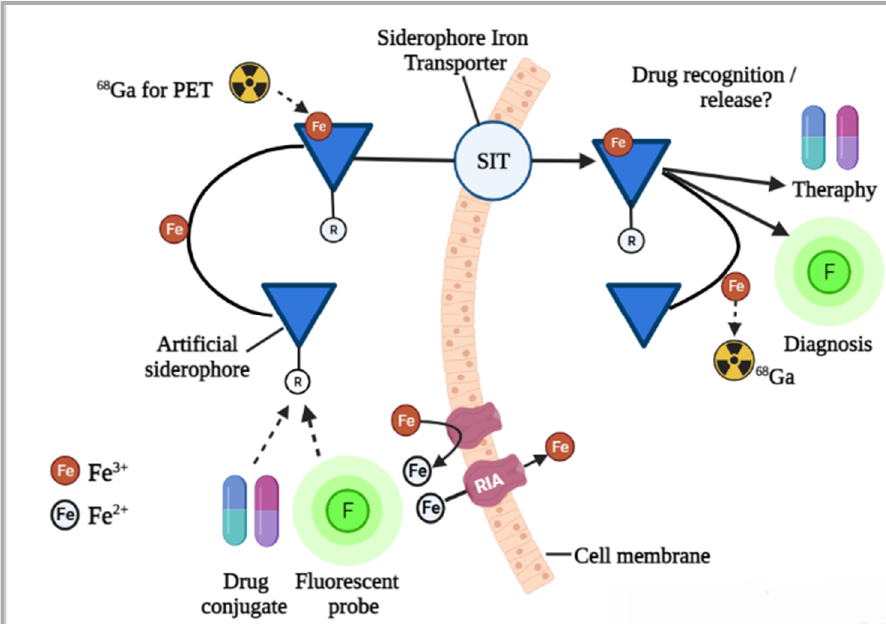
Figure 6. Siderophores for medical applications. The use of different siderophores (natural, artificial, and modified) linked to drugs or fluorescent probes, and 68 Ga radiolabeled for molecular imaging and/or curative practices. Siderophores facilitated intracellular absorption potentially allows diag- nosis through the use of fluorescent or radioactive signal transduction or therapy by introducing antifungal drugs, thus obeying a trojan horse strategy. The siderophores’ metabolic path and trans- lation target is shown by solid line arrows. Substitution of Fe with 68 Ga (for PET) or drug molecules– or fluorescent probes–siderophores conjugate is indicated by dotted line arrows (modified and adapted from Petrik et al. [149].